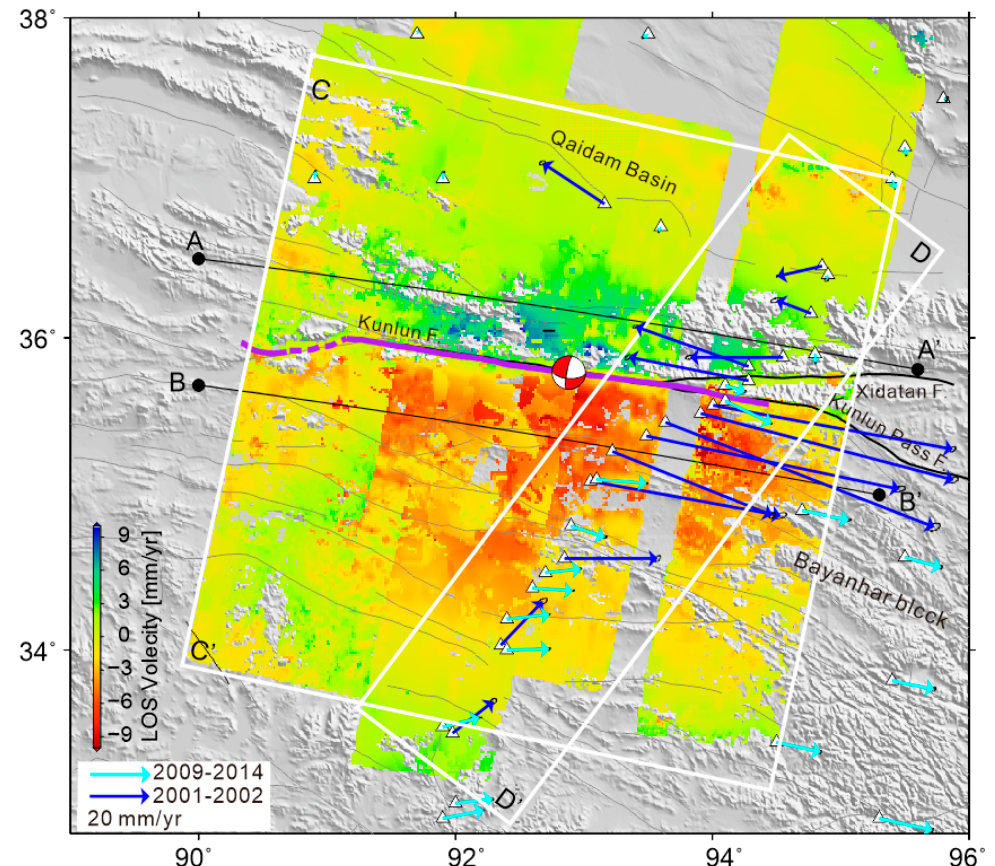
Figure 9. Collage of postseismic LOS rate maps (2003–2010) on five descending tracks 448, 176, 405, 133 and 90. Fault traces, focal mechanism and surface ruptures caused by the 2001 Kokoxili earthquake are as in Figure 1. AA’, BB’, CC’, and DD’ indicate four profile locations for plots in Figures 10 and 13. White triangles show the sites of postseismic GPS observations. The blue (observed in 2001–2002) and cyan (observed in 2009–2014) vectors are GPS velocities from Qiao et al. [23], Ren and Wang [24] and Zhao et al. [25].